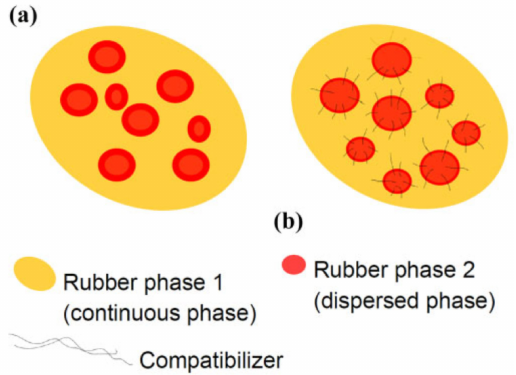
Figure 6. Schematic representation of ( a ) incompatible rubber-rubber blends, and ( b ) compatible rubber-rubber blends